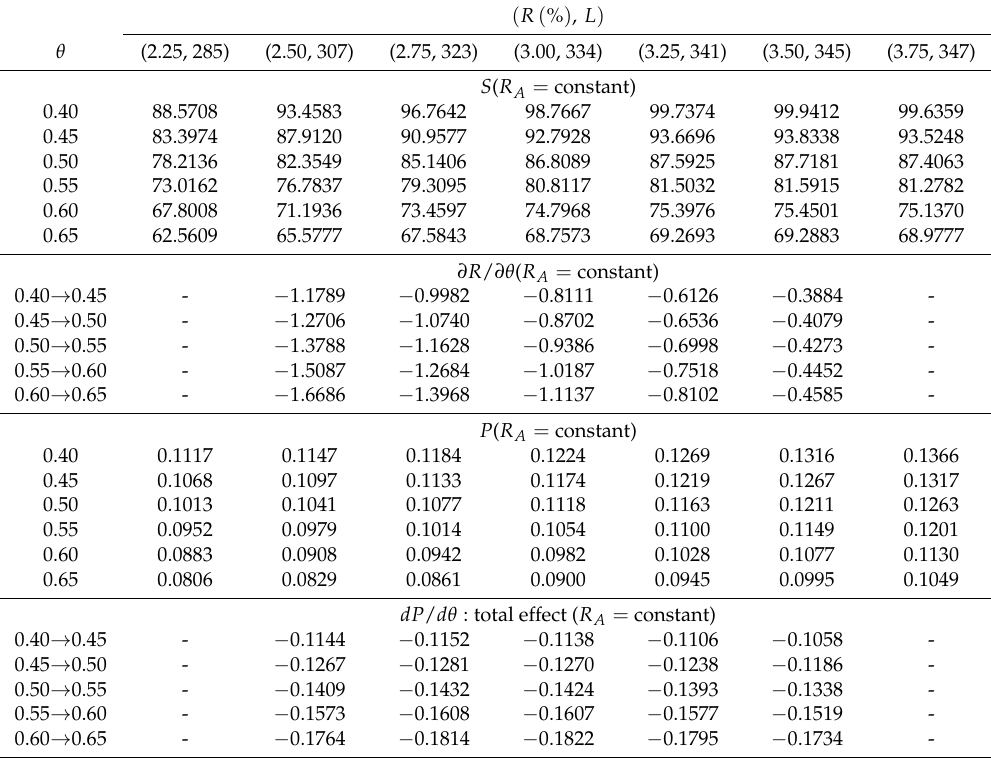
Table 5. Responsiveness of liability-side interest margin (guaranteed interest rate) and default risk to buying distressed assets based on Equations (17) and (19) 1 .